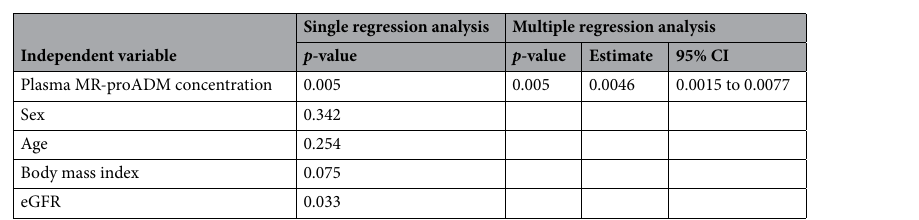
Figure 4. Correlation between mid-regional pro-adrenomedullin (MR-proADM) concentration and weight- corrected treatment intensity score calculated for each antihypertensive drug class: (A) calcium-channel antagonists, (B) ACE inhibitors and ARBs, (C) β blockers and αβ blockers, and (D) diuretics.